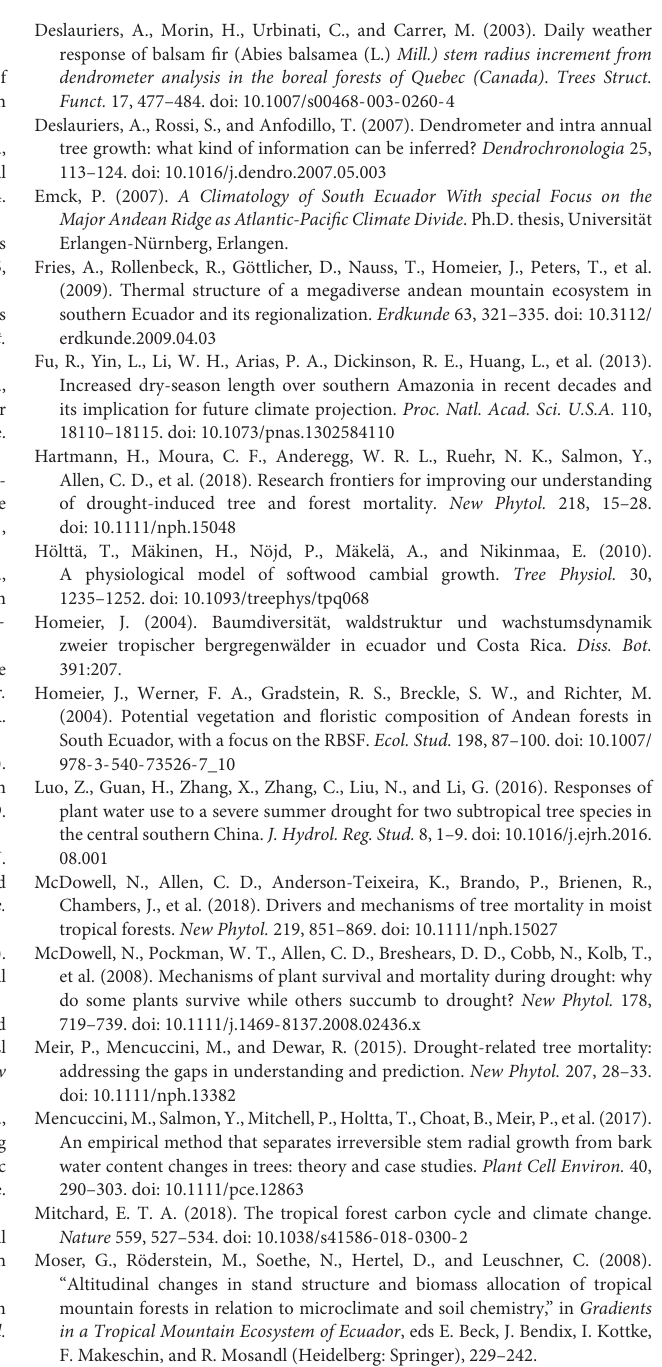
FIGURE S2 | Daily increment and shrinkage maxima (mm) for different genera with standard deviations. FIGURE S3 | Daily increment and shrinkage means (mm) for different genera with standard deviations. FIGURE S4 | Daily increment and shrinkage sums (mm) for different genera with standard deviations. TABLE S1 | Number of dry intervals and the dates they